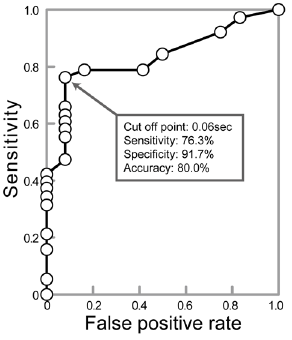
Figure 1. Receiver operating characteristic (ROC) validation of the gap index in the diagnosis of bronchial involvement in patients with central airway obstruction (CAO). ROC validation of the gap index revealed that a cut-off point of 0.06 seconds showed 76.3% sensitivity, 91.7% specificity, and 80% accuracy in the differen- tiation between CAO with bronchial involvement (bronchial=18 and extensive=20) and tracheal obstruction (n=12).